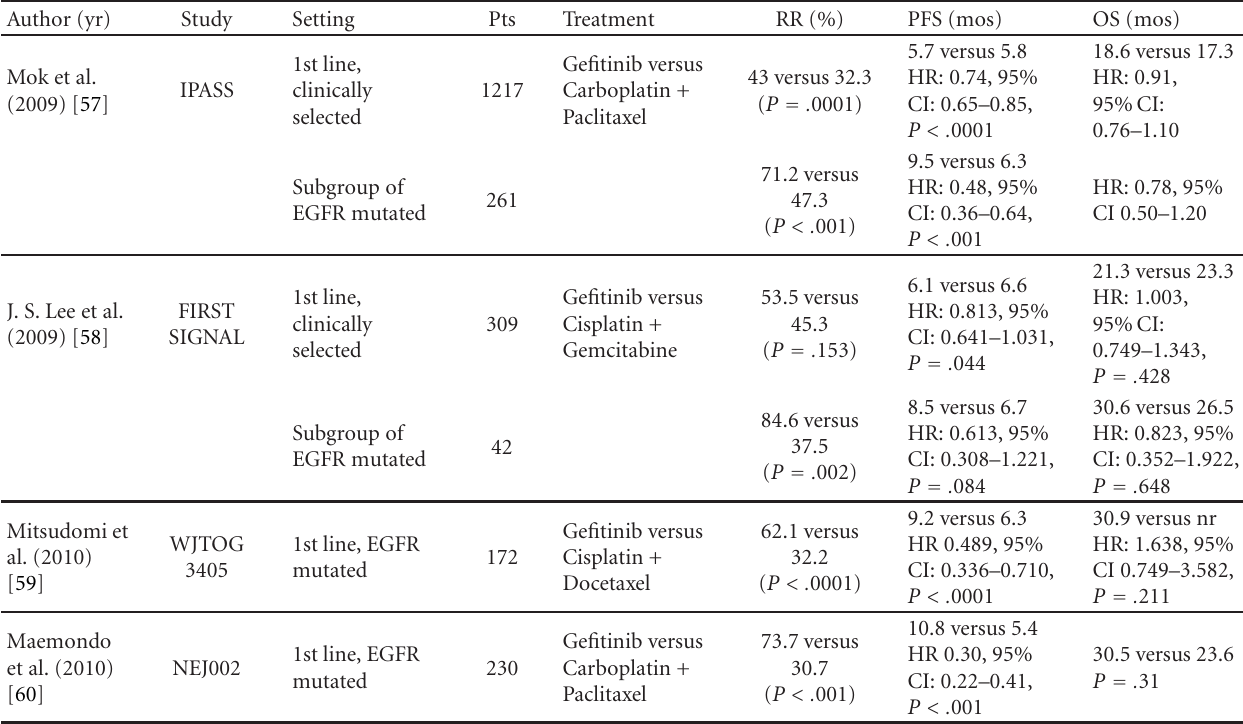
Table 4: Phase III trials with Gefitinib in “selected”